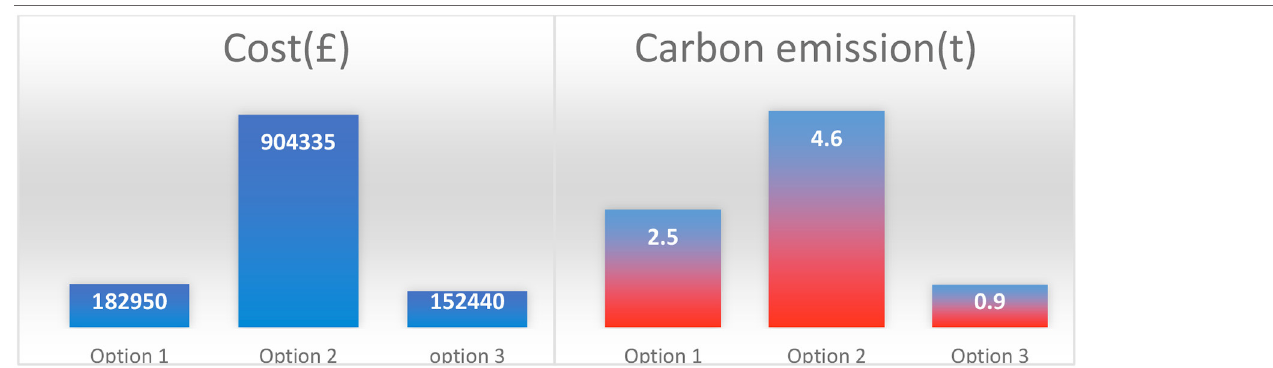
TABLE 1 | Cost estimation and carbon emission calculation of three options.